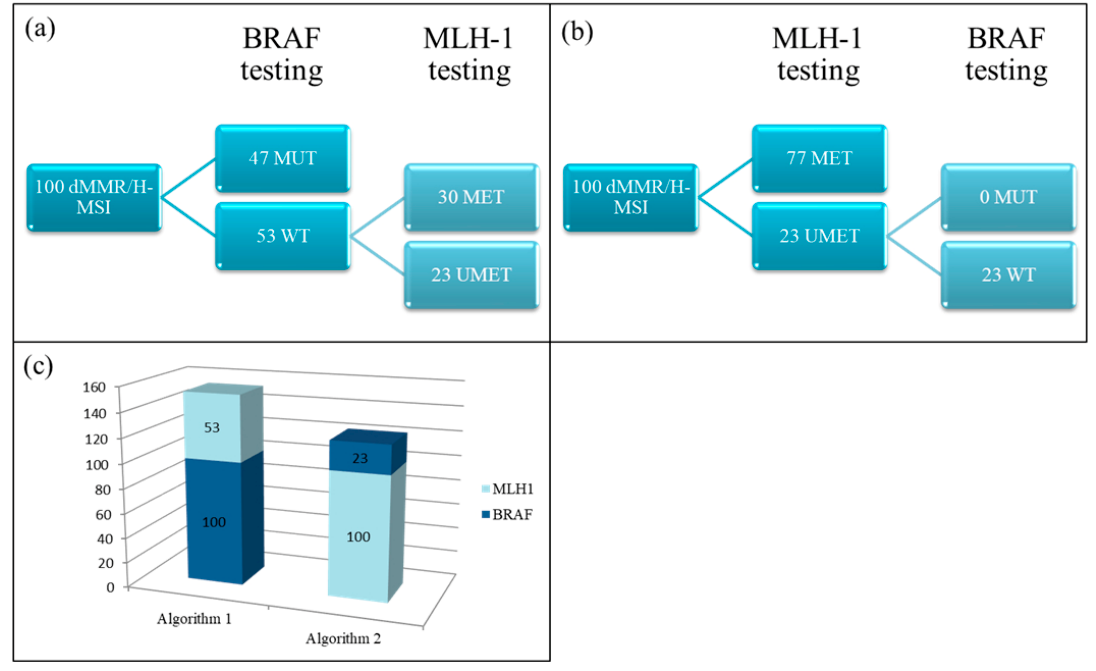
Figure 4. Comparison of the total number of molecular tests for dMMR/MSI-H CRC: ( a ) first BRAF